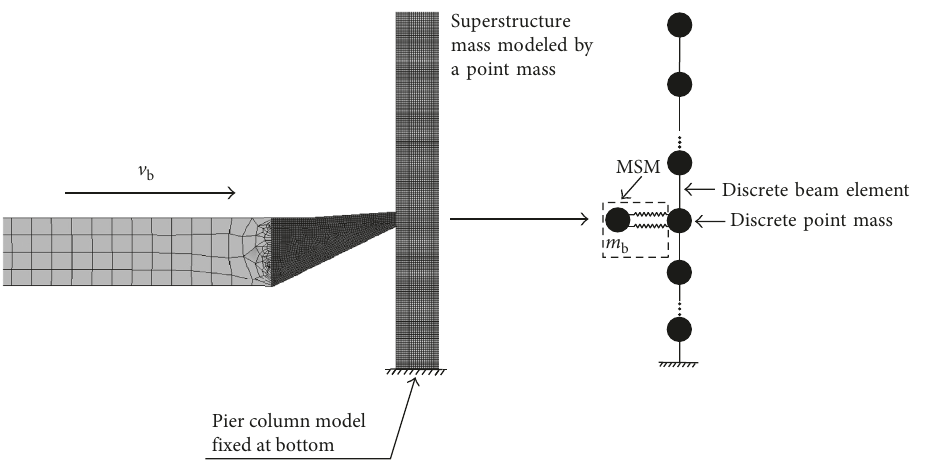
Figure 2: Configuration of (a) the cap steel beam structure and (b) I cross section of steel beams. N l sb : length of each single steel beam; m c : cap mass.